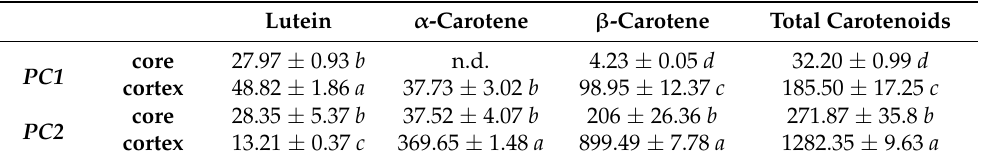
Data are the means ± SDs ( n = 3). n.d. = not detected. Different letters in the same column indicate statistically significant differences at p ≤ 0.05.